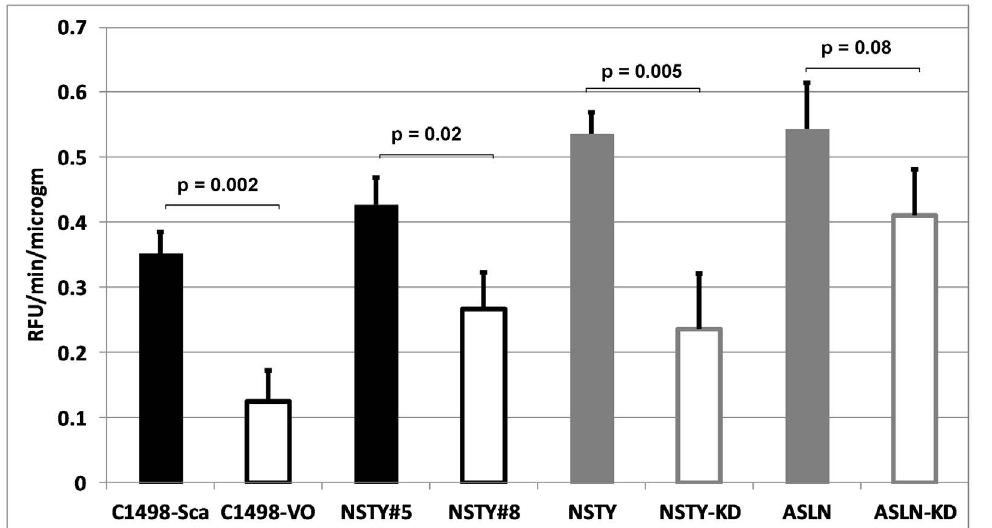
Figure 6. Greater metalloproteinase activity is observed in leukemia cells with greater expression of Ly6a/Sca-1. In vitro proteinase assays were performed in triplicate on cell lysates and expressed as relative fluorescence units per minute per microgram of protein. Filled bars represent leukemia lines with greater Ly6a/Sca-1 expression while white bars are those with low Ly6a/Sca-1 expression. ‘‘C1498-VO’’ is the C1498- vector only control, while ‘‘C1498-Sca’’ is C1498-Ly6a/Sca-1. ‘‘NSTY # 8’’ is the NSTY leukemia clone 8 isolated by limiting dilution that has low levels of Ly6a/Sca-1 while ‘‘NSTY # 5’’ is clone 5 which has high levels of Ly6a/Sca-1. ‘‘NSTY’’ is the NSTY line transduced with the lentivirus control vector while ‘‘NSTY-KD’’ is NSTY transduced with the anti-Ly6a/Sca-1 shRNA vector. For the ASLN leukemia ‘‘ASLN’’ and ‘‘ASLN-KD’’ have similar meanings. Bars are average and the error bars are standard variation. N=3 per sample. P values for each comparison were calculated with t-tests.